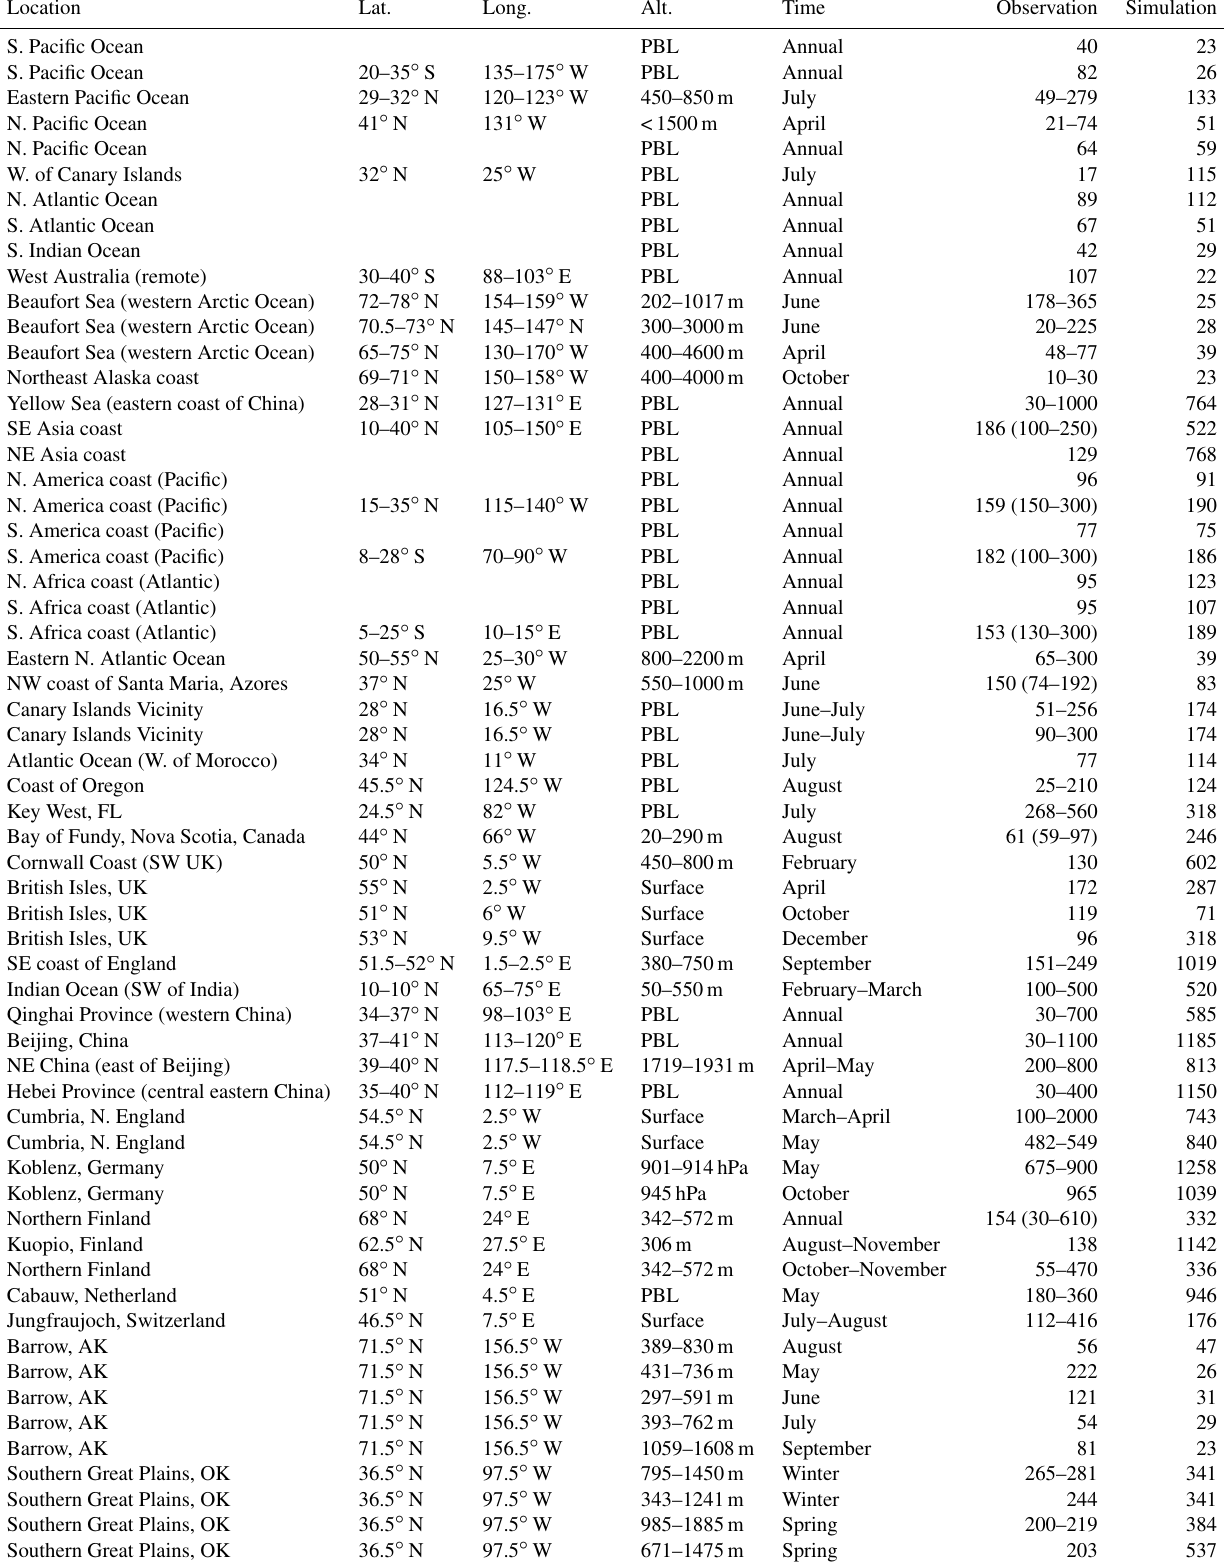
Table 1. Comparison of simulated and observed (Karydis et al., 2011a, and references therein) cloud droplet number concentrations.